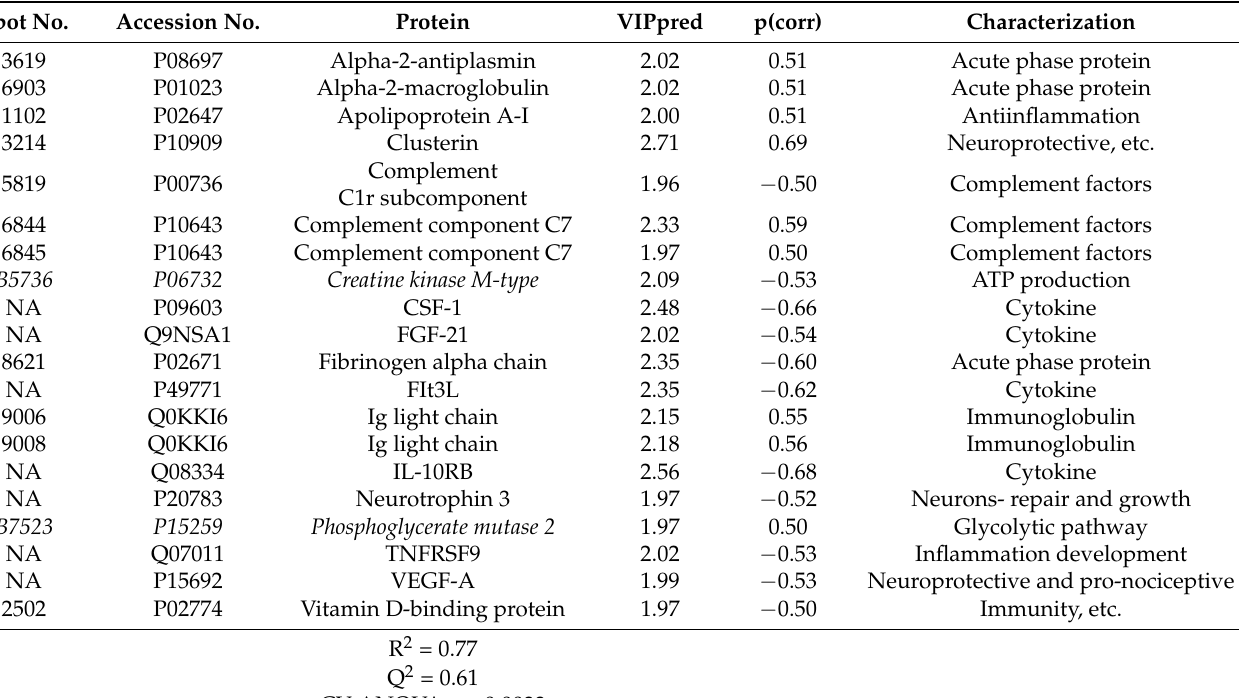
Table 5. OPLS regression of HPT in CWP; significant proteins (in alphabetical order) are presented according to VIPpred. Characterization is based on brief reviews (Text S2). Proteins in italics are muscle proteins and the others are plasma proteins. A negative sign for p(corr) indicates that high level of the protein is associated with a low pain threshold for heat